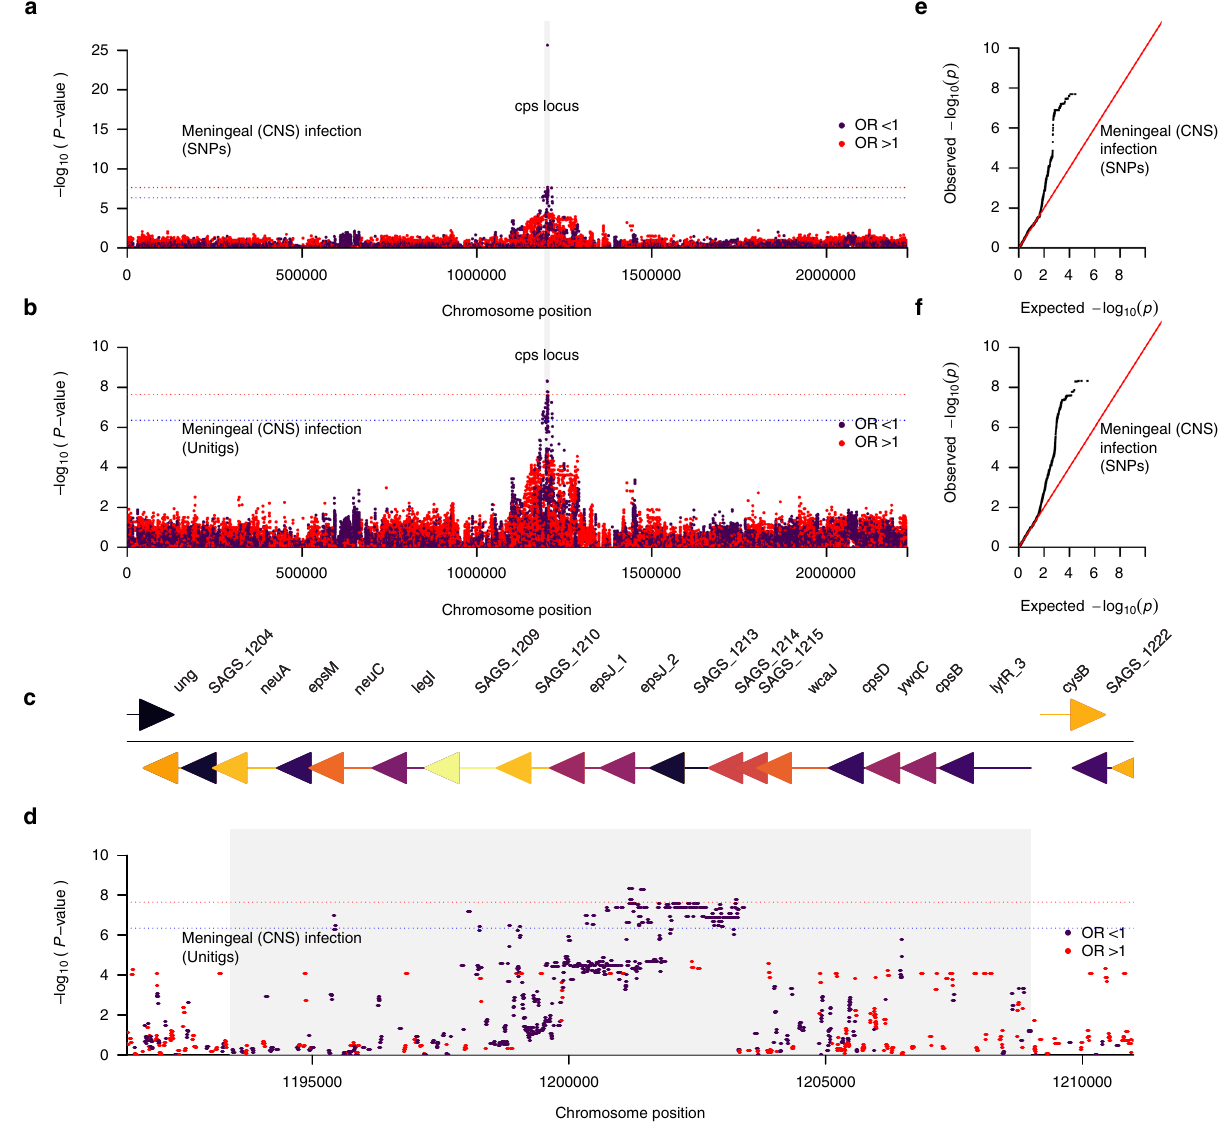
Fig. 5 Manhattan plots showing the association between GBS genomic variation and the CNS infection status. Statistical signi fi cance ( – log 10 [ P -value]) of the GBS genomic variants based on the likelihood ratio test are coloured by the exponentiated linear mixed model coef fi cients or odds ratio as the target variable in the GWAS. a SNP-based GWAS and b unitig-based GWAS using CNS infection status of the GBS isolates as the target variable speci fi ed as isolation from the CNS or non-CNS tissue. c Genomic features in the GBS capsular polysaccharide ( cps ) locus, and d corresponding Zoom plot showing the statistical signi fi cance and location of the genetic variants (unitigs), which mapped to the cps region of the complete GBS reference genome (GenBank accession: AP018935.1). Q – Q plots showing the relationship between the observed statistical signi fi cance and the expected statistical signi fi cance for e SNP-based GWAS, and f Unitig-based GWAS using body isolation tissue as the target variable. The red and blue dotted lines represent the genome-wide signi fi cance and suggestive threshold, respectively. The variants with odds ratios (OR) > 1 is coloured in red while those with odds ratio <1 is coloured in dark purple. Source data for panel a – f is available in Supplementary Data 4 and on GitHub Additionally, we identi fi ed a total of 123 suggestive unitigs mostly when controlling the population structure (Fig. 4e, f). Com- mapping to the cps locus and other genomic region (Supple- plementary GWAS based on the presence and absence of acces- mentary Data 4). The cps genes tagged by the unitigs included sory genes revealed a single statistically signi fi cant association for those encoding a multidrug major facilitator superfamily (MFS) a phosphopentomutase encoding gene, and two suggestive hits transporter ( cpsG ), glycosyltransferase CpsJ ( cpsJ ), a capsular for capsular biosynthesis genes (Supplementary Fig. 6c). Alto- polysaccharide biosynthesis protein CpsA ( cpsA ), and a polysialic gether, these fi ndings suggested that genetic variation within the acid biosynthesis protein P7 ( neuC ) while the other genes capsule biosynthesis locus in fl uences bloodstream-to-meningeal fl anking the cps locus, included DNA topoisomerase 4 subunit A tissue invasion and potentially survival in the CNS. (parC), DNA topoisomerase IV subunit B (gyrB) and an arsenate reductase (arsC) (Fig. 5c). Consistent with the GWAS of the disease onset time outcome, the Q – Q plots for the analysis based Genetic variation for CNS invasion varies by GBS serotype . To on the CNS infection phenotype suggested no apparent issues understand the distribution of identi fi ed genetic variants within